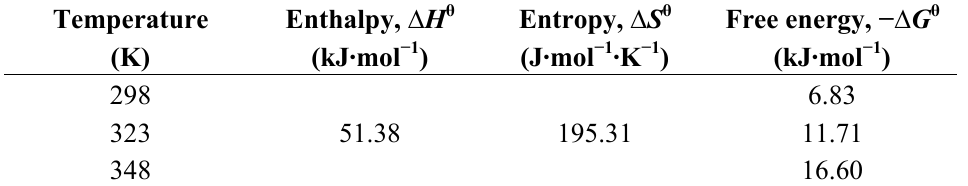
Table 2. Thermodynamic parameters of nickel (II) adsorption onto peh-g-opefb. Temperature Enthalpy, ∆ H (K)